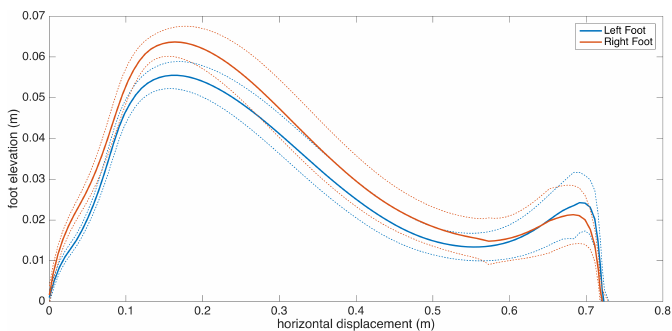
Figure 17. Even footfall as demonstrated by lower secondary peaks (Subject